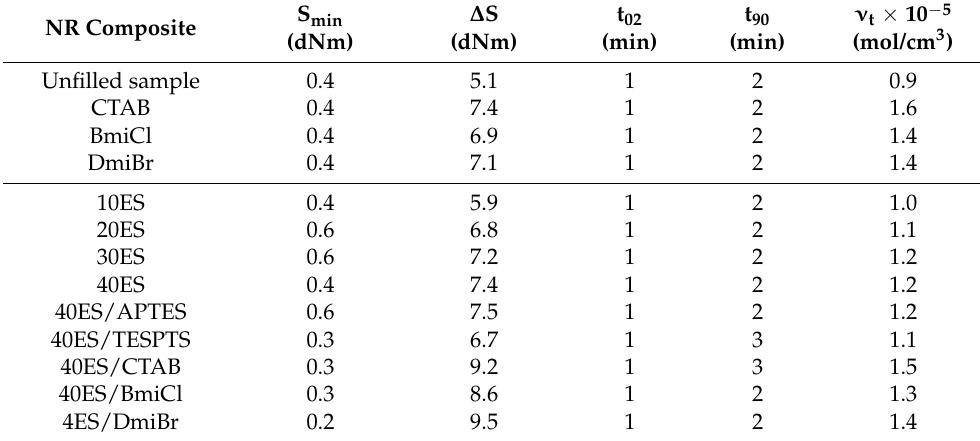
Table 4. Cure characteristics of NR compounds at 160 ◦ C (S min —minimum torque, ∆ S—increment of torque during vulcanization, t 02 —scorch time, t 90 —optimal vulcanization time. SD: S min ± 0.2 dNm,